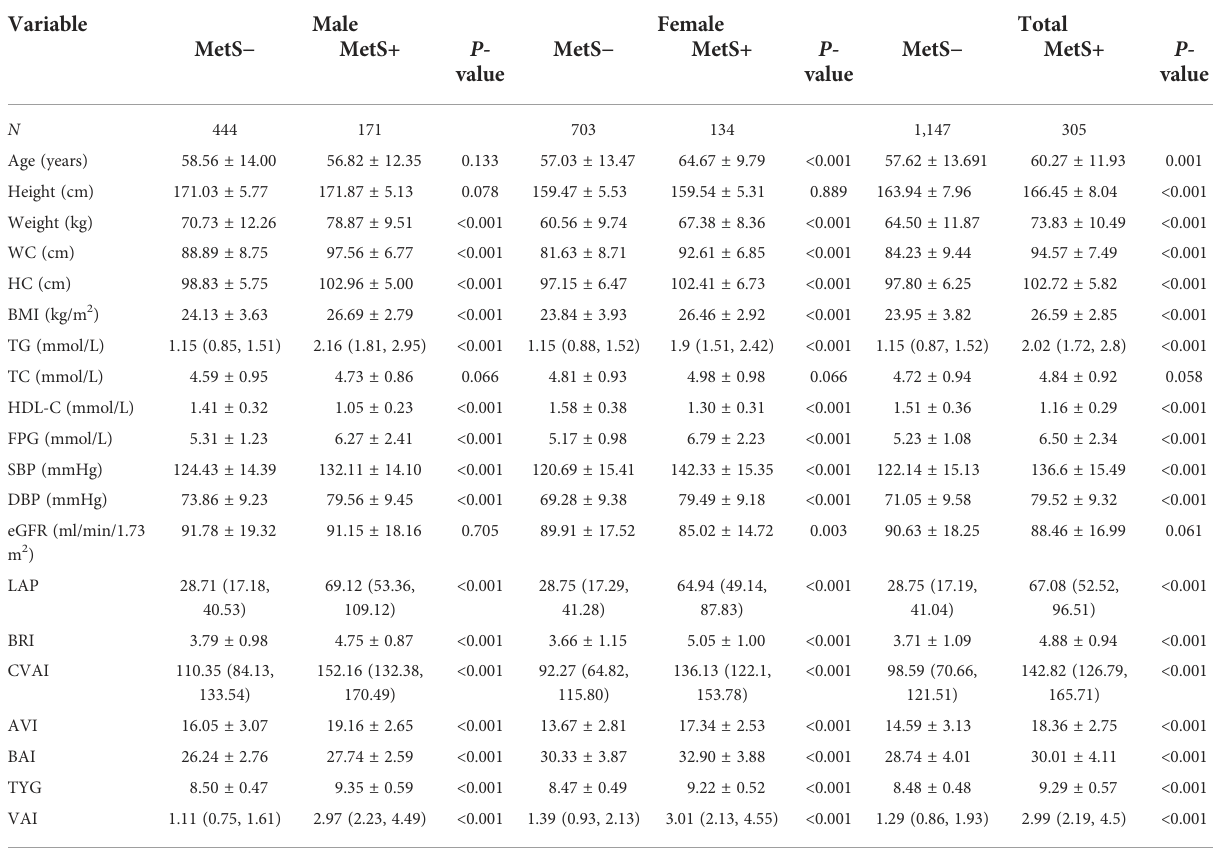
TABLE 2 Characteristics of participants with or without MetS (China 2020).